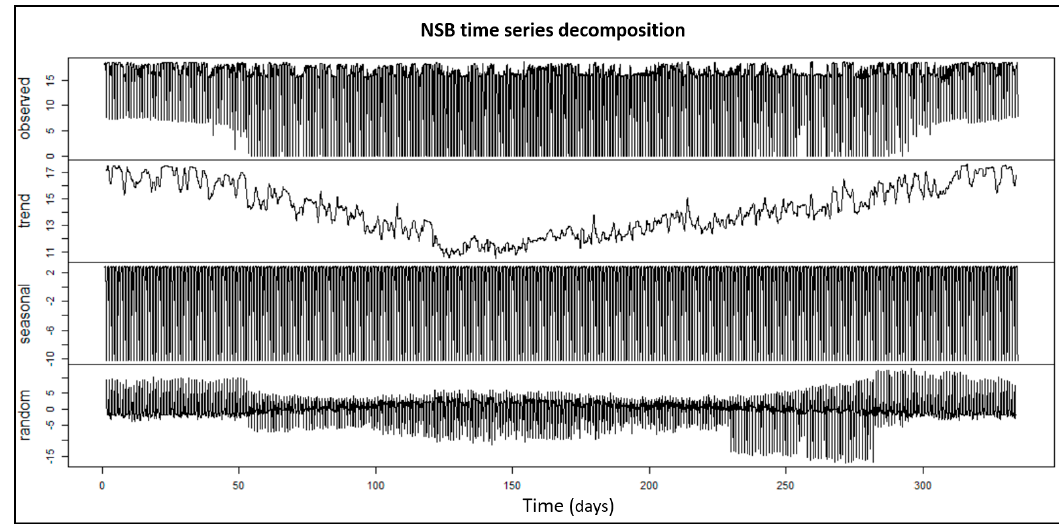
Figure 3. Additive decomposition for NSB time series for the whole of 2017 taken in the National Astronomical Observatory of Japan.